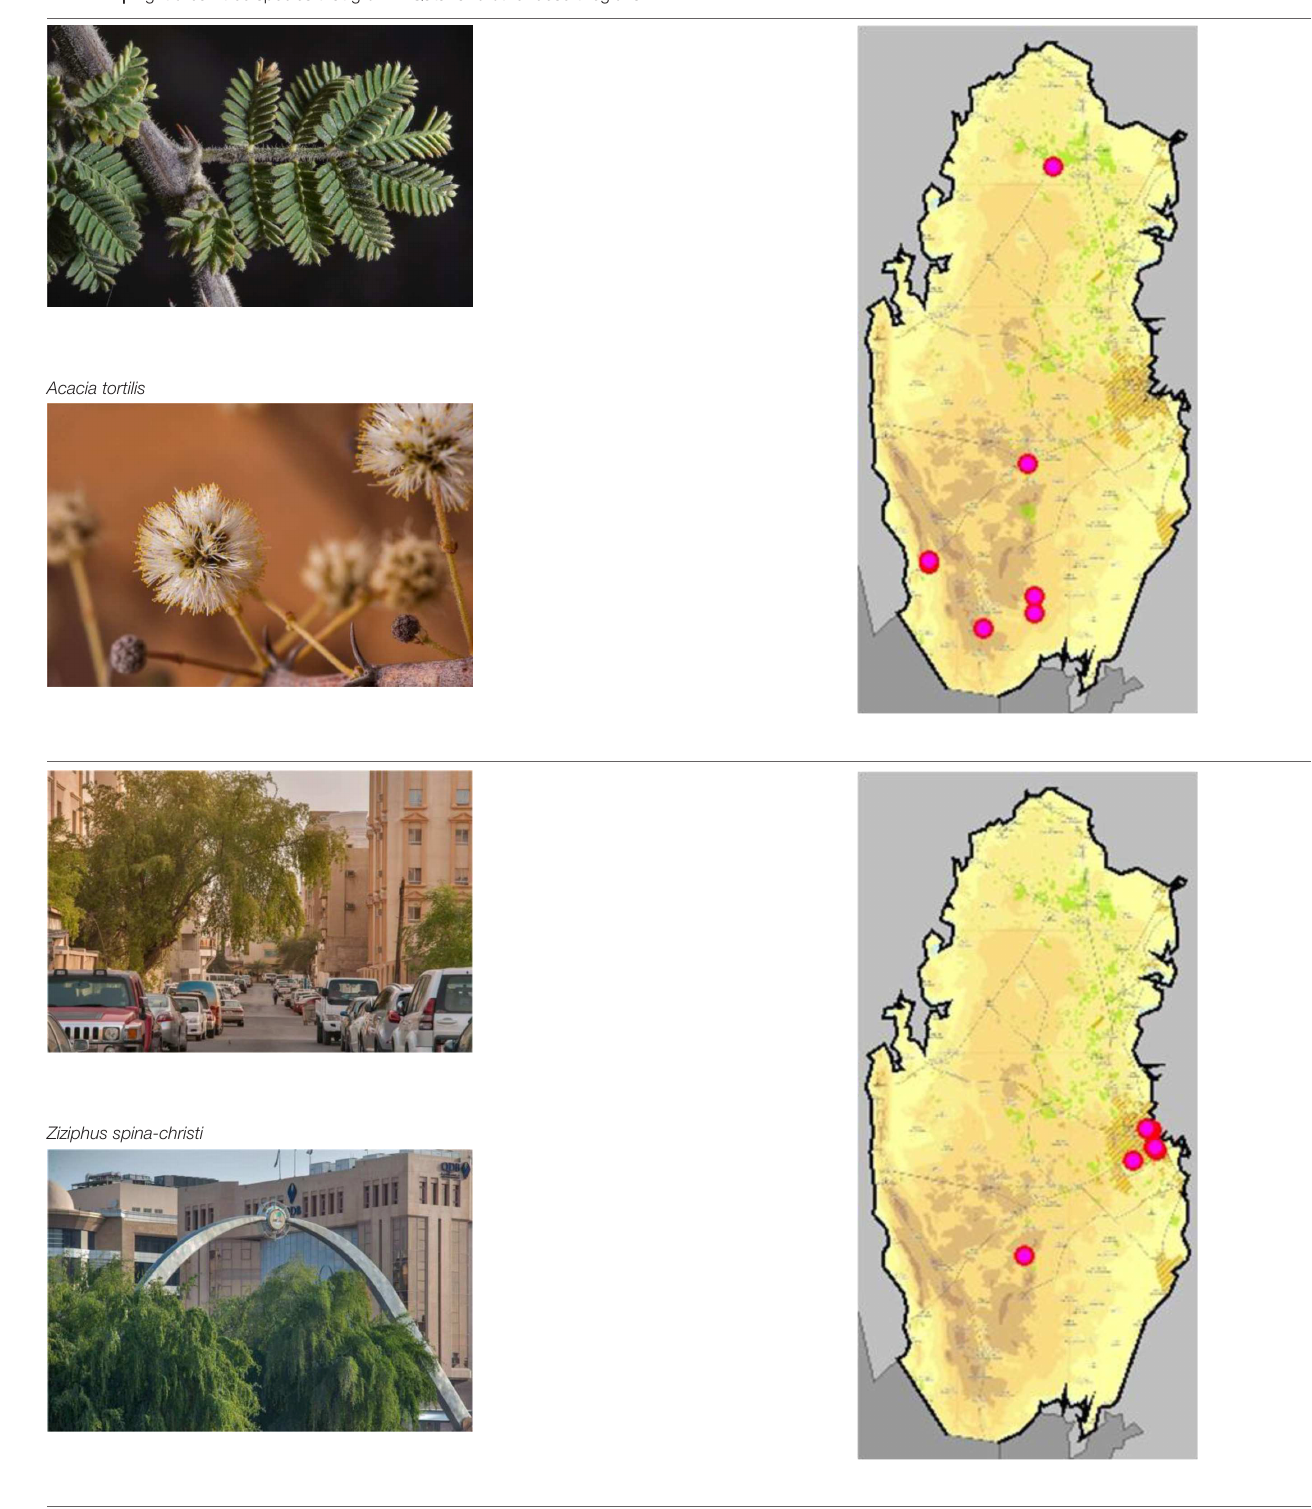
TABLE 1 | Eight urban tree species that grow in Qatar and other desert